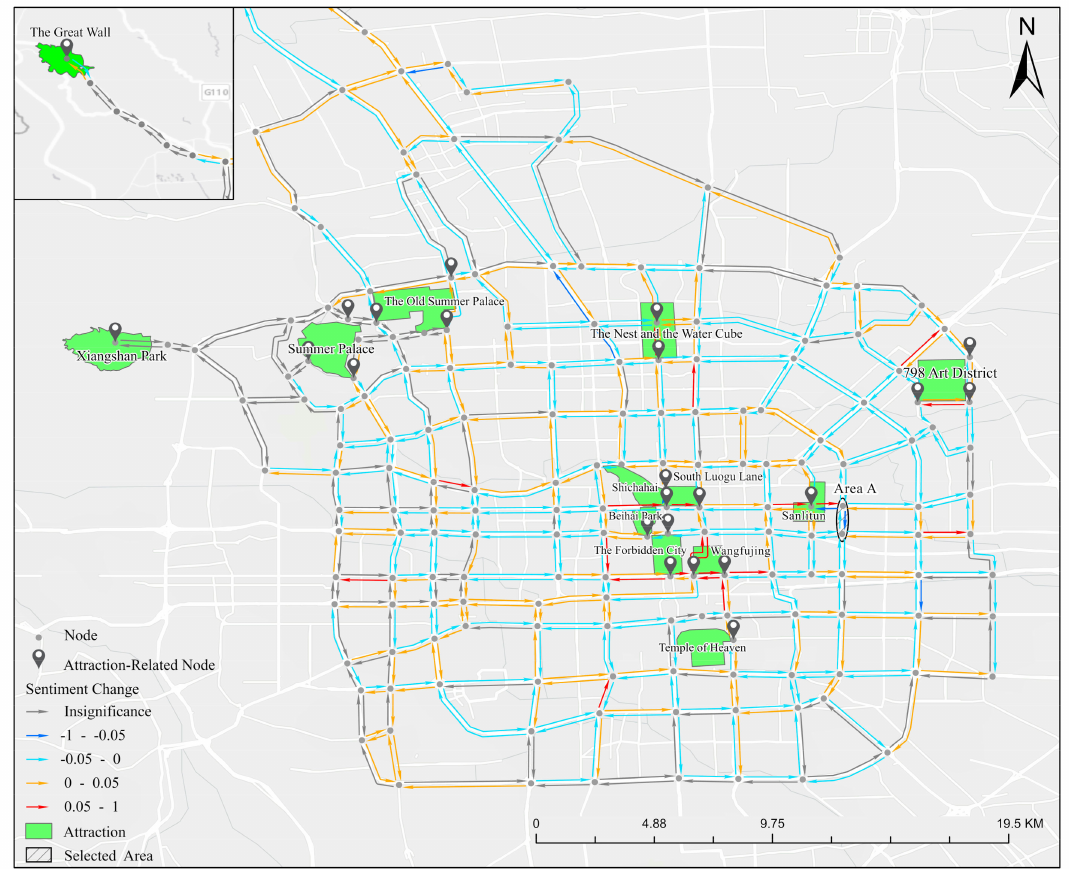
Figure A4. The spatial distribution of sentiment change in tourist flow in the nighttime.